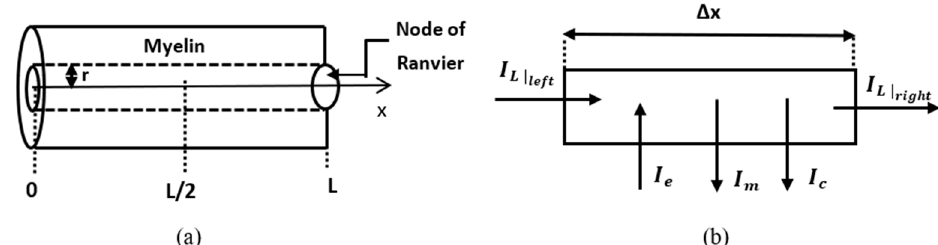
Figure 2. ( a ) One part of a neuron consisting of an internodal (myelinated) region of length L and a node of Ranvier at x = L . The radius of the axon is denoted by r . The computational domain for the dynamic problem is [ L /2, L ] . ( b ) The electric currents entering (the longitudinal current I L | left and external current I e ) and exiting (the longitudinal current I L | right , the membrane current I m , and the capacitor current I c ) a neuronal segment of length ∆ x .